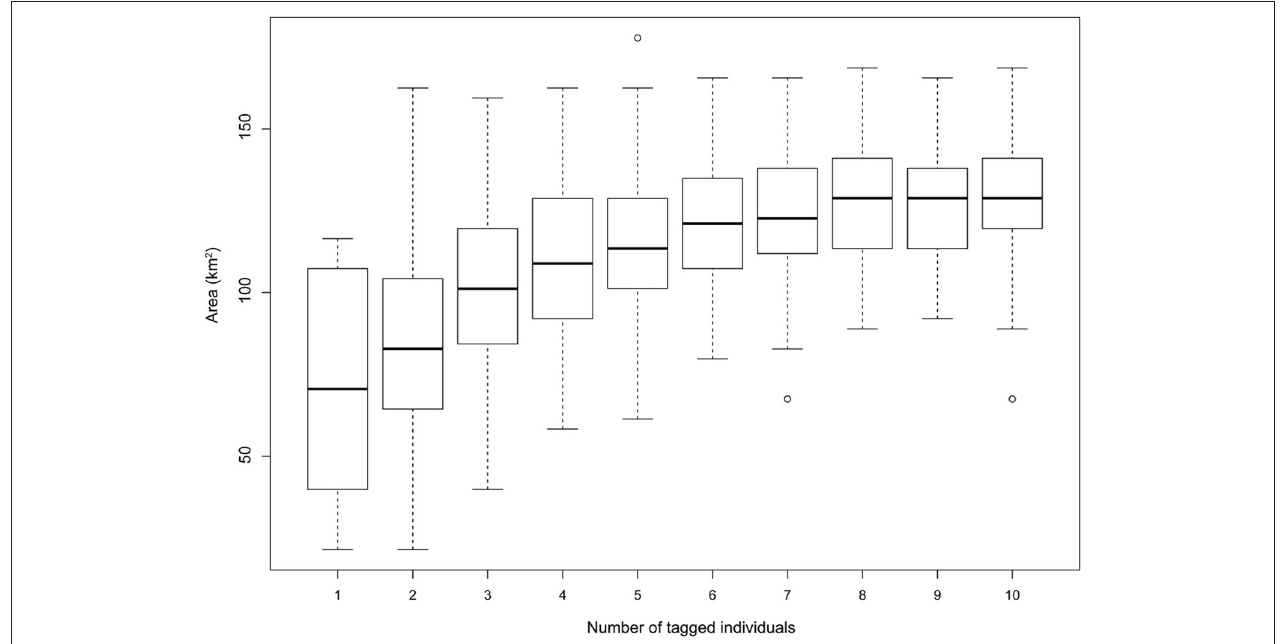
FIGURE 6 | Home range size (km 2 ) at the 90% UD contour as individuals are iteratively added to gridded UD home range calculations. 100 permutations were conducted across all potential number of individuals (1–10), for a total of 1000 permutations. An asymptote was reached after ∼ 6 individuals indicating that our sample size of 10 individuals is likely representative of the larger population within our study